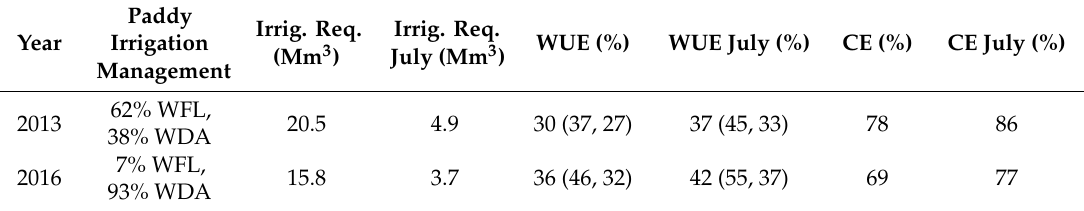
Table 3. District total irrigation requirements (Irrig. Req.), water use e ffi ciency of the agricultural area (WUE) and channel network e ffi ciency (CE), calculated for the whole 2013 and 2016 agricultural seasons and for the month of July. WUE values for shallow and deep groundwater zones are reported in brackets. WFL and WDA express the share of traditional wet seeding and continuous flooding and wetting and drying alternate irrigation management over the district, respectively.